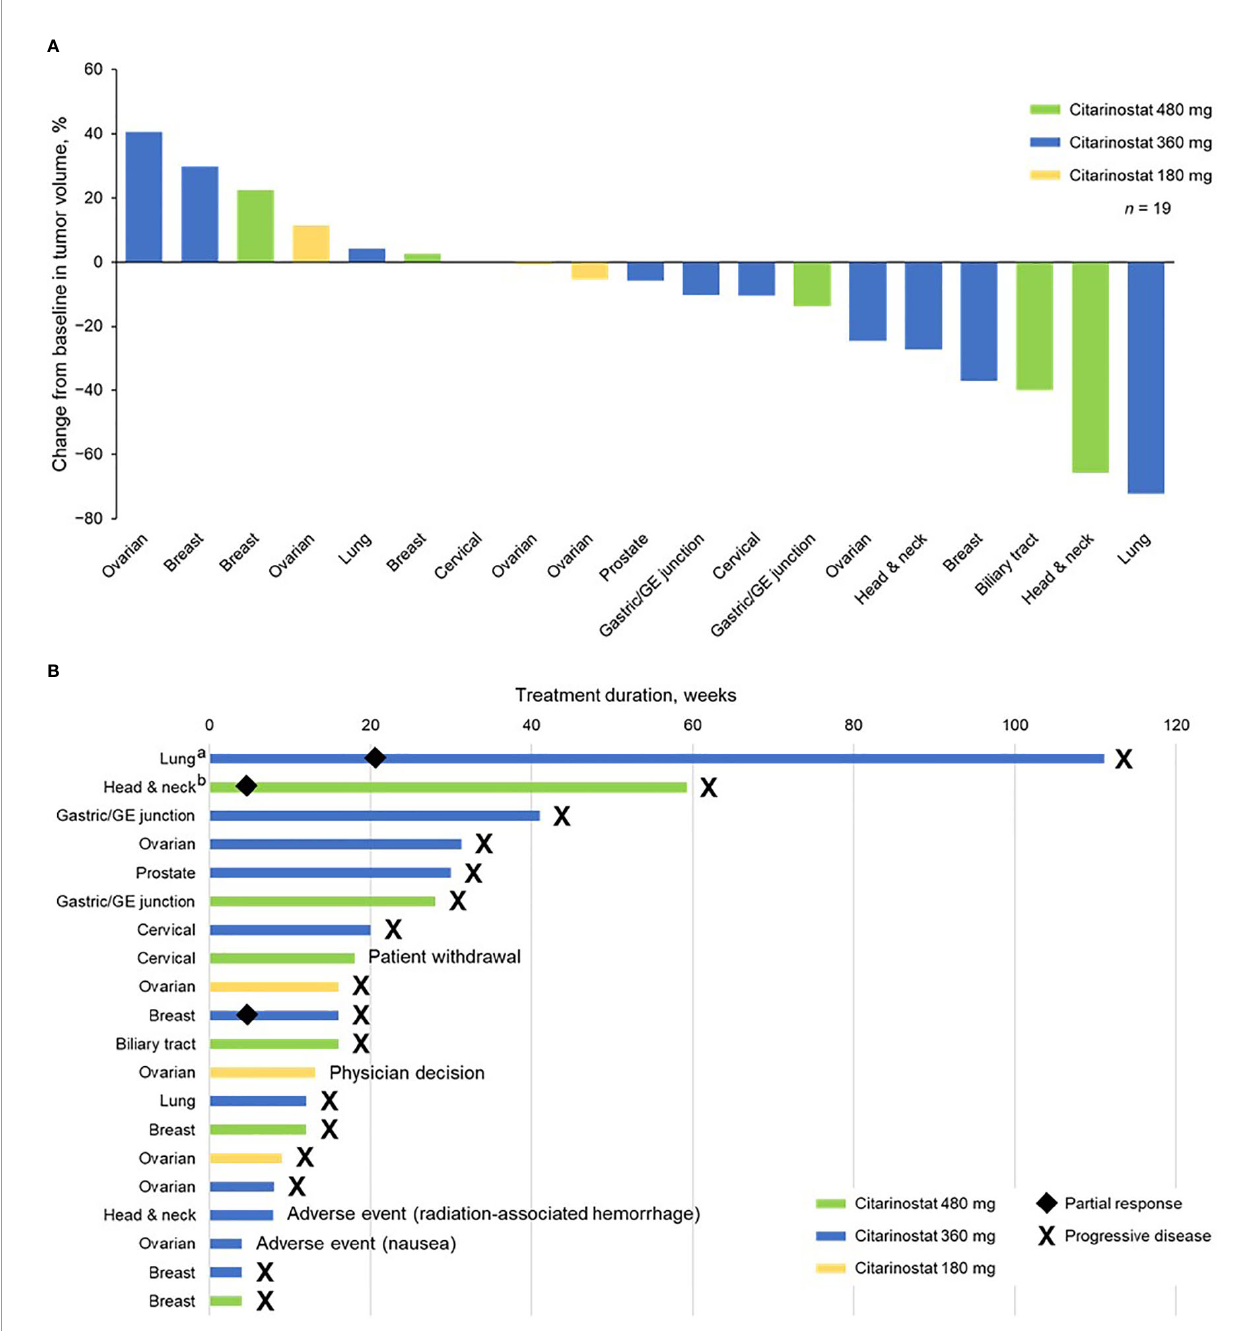
FIGURE 2 | (A) Tumor shrinkage by enrolled population (1 patient with ovarian cancer did not have a postbaseline ef fi cacy assessment and was not included in this analysis) and (B) treatment duration by individual patients (safety population). a Received citarinostat as monotherapy beginning in cycle 25. b Received citarinostat as monotherapy beginning in cycle 11 (paclitaxel withdrawn due to grade 3 neuropathy). GE,